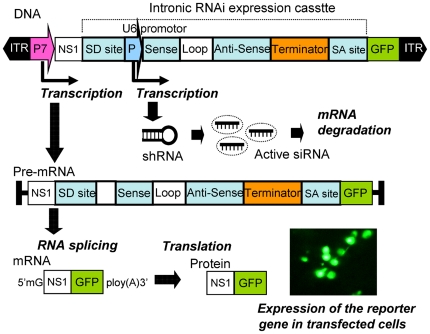
Pol III-mediated intronic siRNA expression vector.Intronic shRNA is transcribed by the U6 promoter accompanied by a pre-mRNA transcribed by the p7 promoter. After pre-mRNA splicing, the exons are ligated to form a mature mRNA. For NS1-GFP fusion protein synthesis, the shRNA is further processed into mature siRNA capable of triggering post-transcriptional gene silencing.